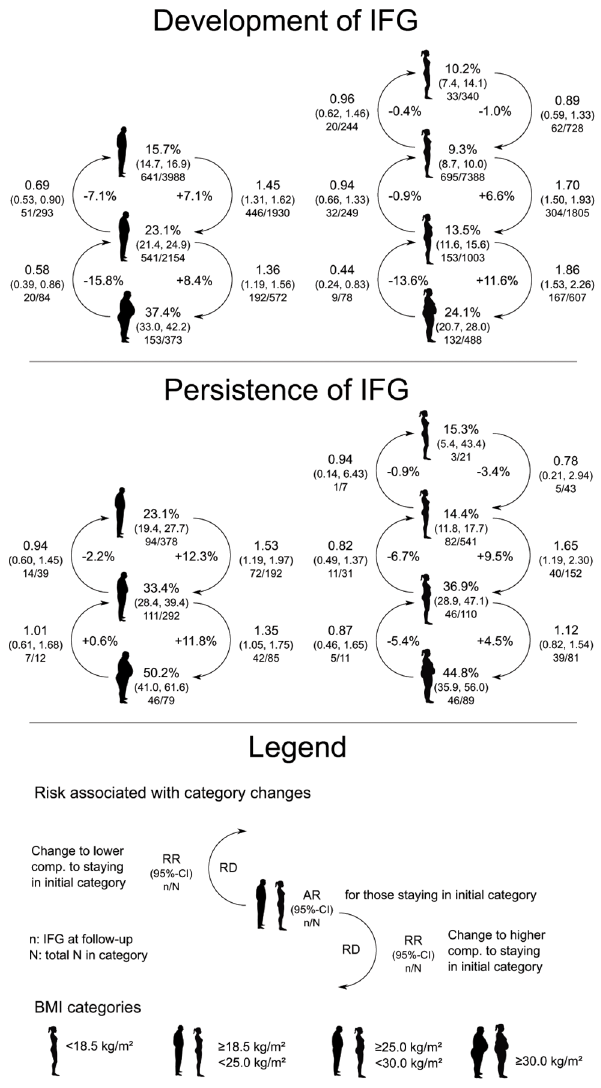
Fig 1. IFG risk by BMI category and category change. Absolute risk (AR) for development and persistence of impaired fasting glucose by BMI category, and relative risk (RR), risk difference (RD) associated with upward or downward change in BMI category for 30 year old women and